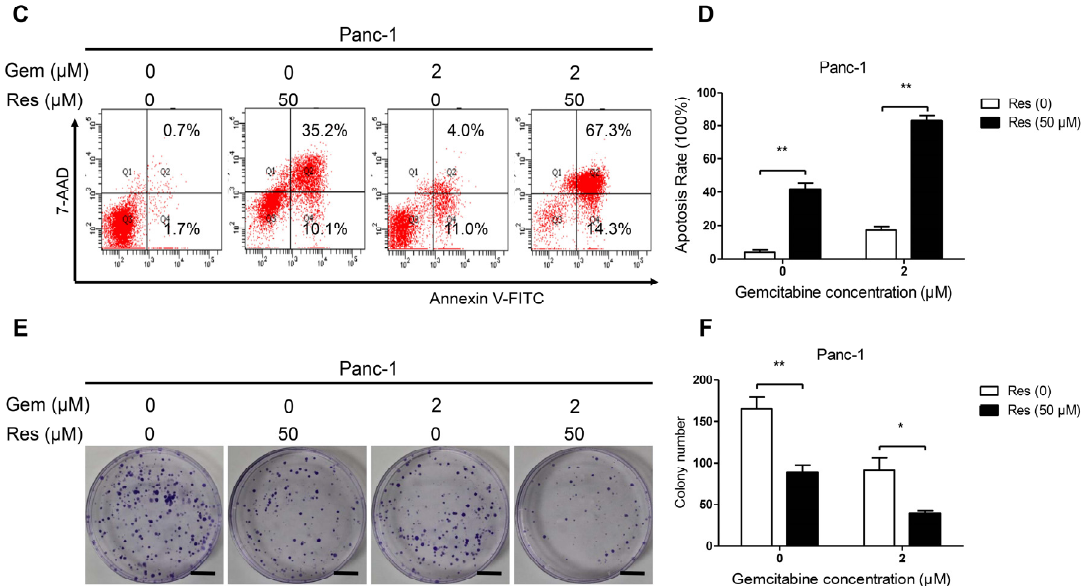
Figure 6. Inhibition of YAP activity by resveratrol enhances the sensitivity of pancreatic cancer cells to gemcitabine. ( A ) Panc-1 cells were treated with gemcitabine (2 µ M) and resveratrol (50 µ M) for 72 h. Cell viability was assessed by the MTT assay; ( B ) Panc-1 cells were treated with gemcitabine (2 µ M) and resveratrol (50 µ M) for 24 h. The protein expression levels of YAP and p-YAP (Ser127) were examined by Western blot analysis using β -actin as an internal loading control; ( C , D ) Panc-1 cells were treated with gemcitabine (Gem) (2 µ M) and resveratrol (50 µ M) for 48 h. Apoptosis was detected by flow cytometry; ( E , F ) The combined effects of Res and Gem on Panc-1 cell clones’ colony-forming ability was detected. Images are representative of three independent experiments (Scale bar: 1 cm). Column: Mean, bar: SD, * p < 0.05, ** p < 0.01.